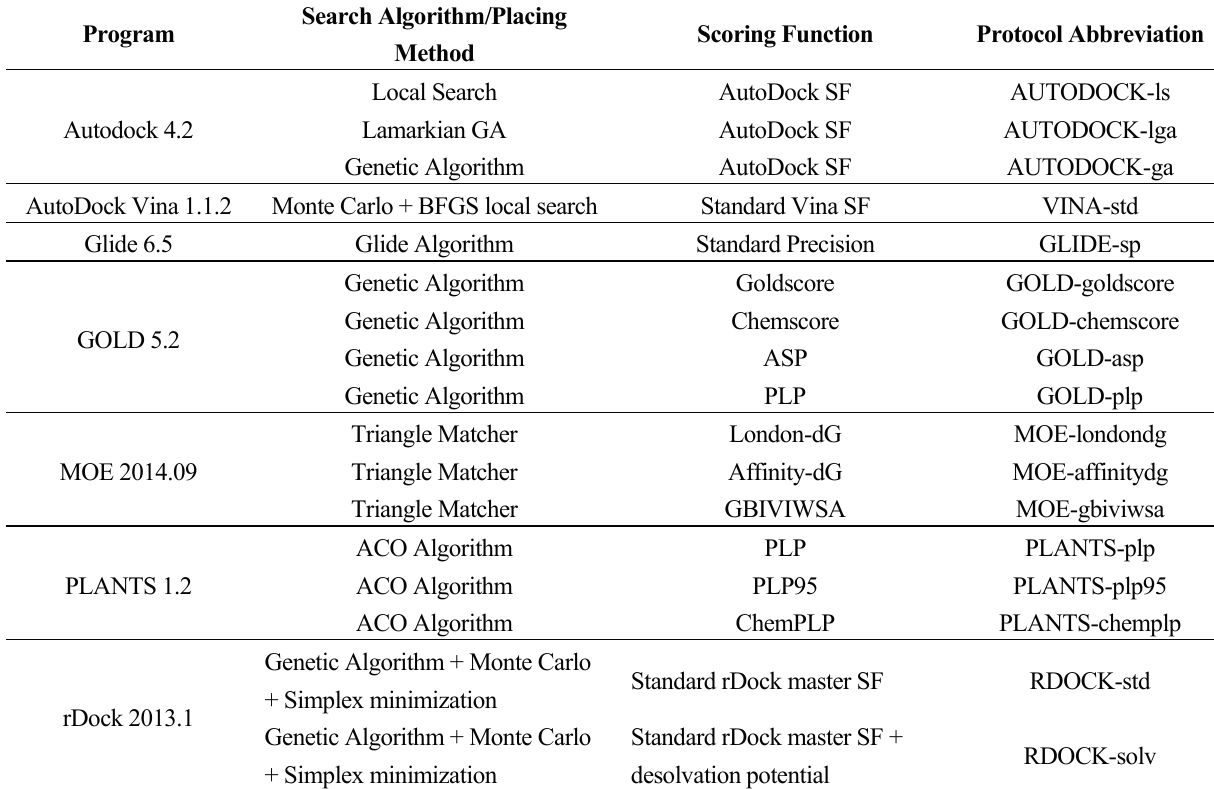
Table 1. List of docking protocols available in DockBench